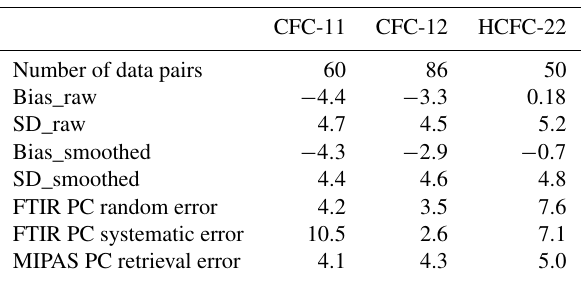
columns of CFC-11, CFC-12 and HCFC-22, respectively, are 0.6 ± 0.1, 0.9 ± 0.1 and 0.6 ± 0.1. Table 4 exhibits the statistical values of the comparison: relative bias and stan- dard deviation of the difference between the MIPAS (raw and smoothed) and FTIR, together with the partial column uncer- tainties from both data sets. The largest mean relative bias is found for CFC-11 ( − 4 . 3 %), showing that the FTIR partial columns are larger than the MIPAS ones, which is proba- bly caused by the large systematic error of FTIR CFC-11 retrievals (10.5 %). For CFC-12, the bias is − 2 . 7 %, which is also within the uncertainty budget of combined data sets. The lowest relative bias is found for HCFC-22 ( − 0 . 7 %), but the standard deviation is still large (4.8 %) because of the large FTIR retrieval errors (7 . 6 / 7 . 1 %) and MIPAS retrieval error (5.0 %). Overall, the biases and standard deviations between the two data sets lie within the uncertainty budgets for the three